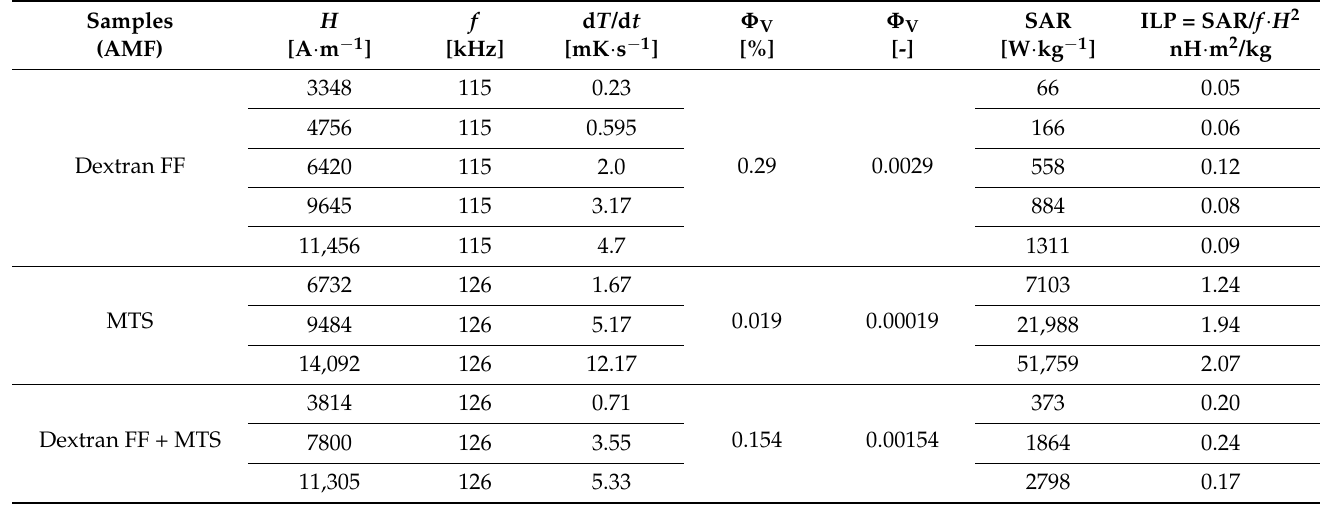
Table 3. RMF parameters ( H and f) and heating rate (d T /d t ) of tested magnetic samples.